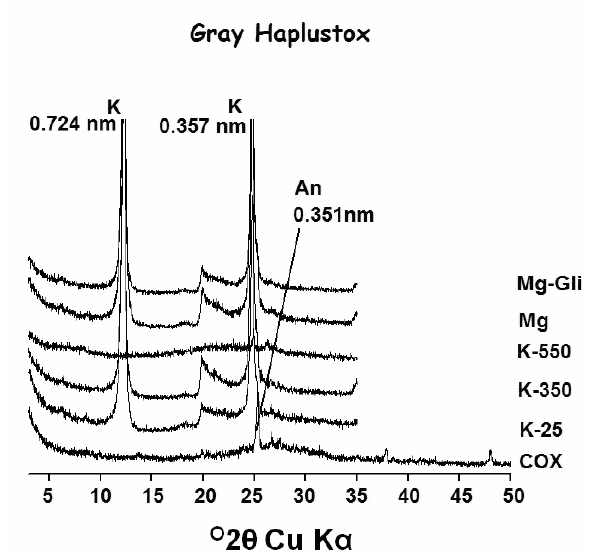
Figure 2. X ray diffractograms of the deferrified clay fraction and oxide concentrations in the Bw horizon of the “Gray Haplustox” (“LAC”). K: Kaolinite and An: Anatase.